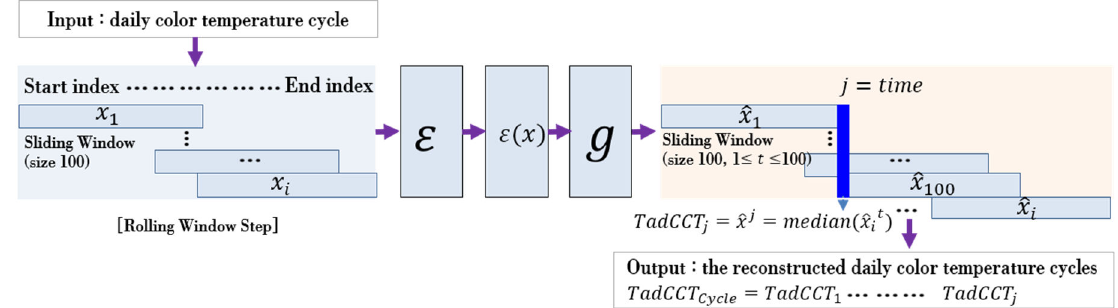
Figure 4. Color temperature generation process of TadGAN.